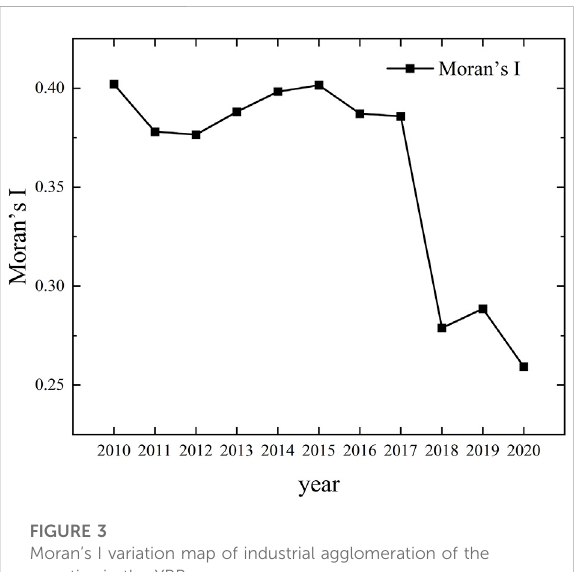
FIGURE 3 Moran ’ s I variation map of industrial agglomeration of the counties in the